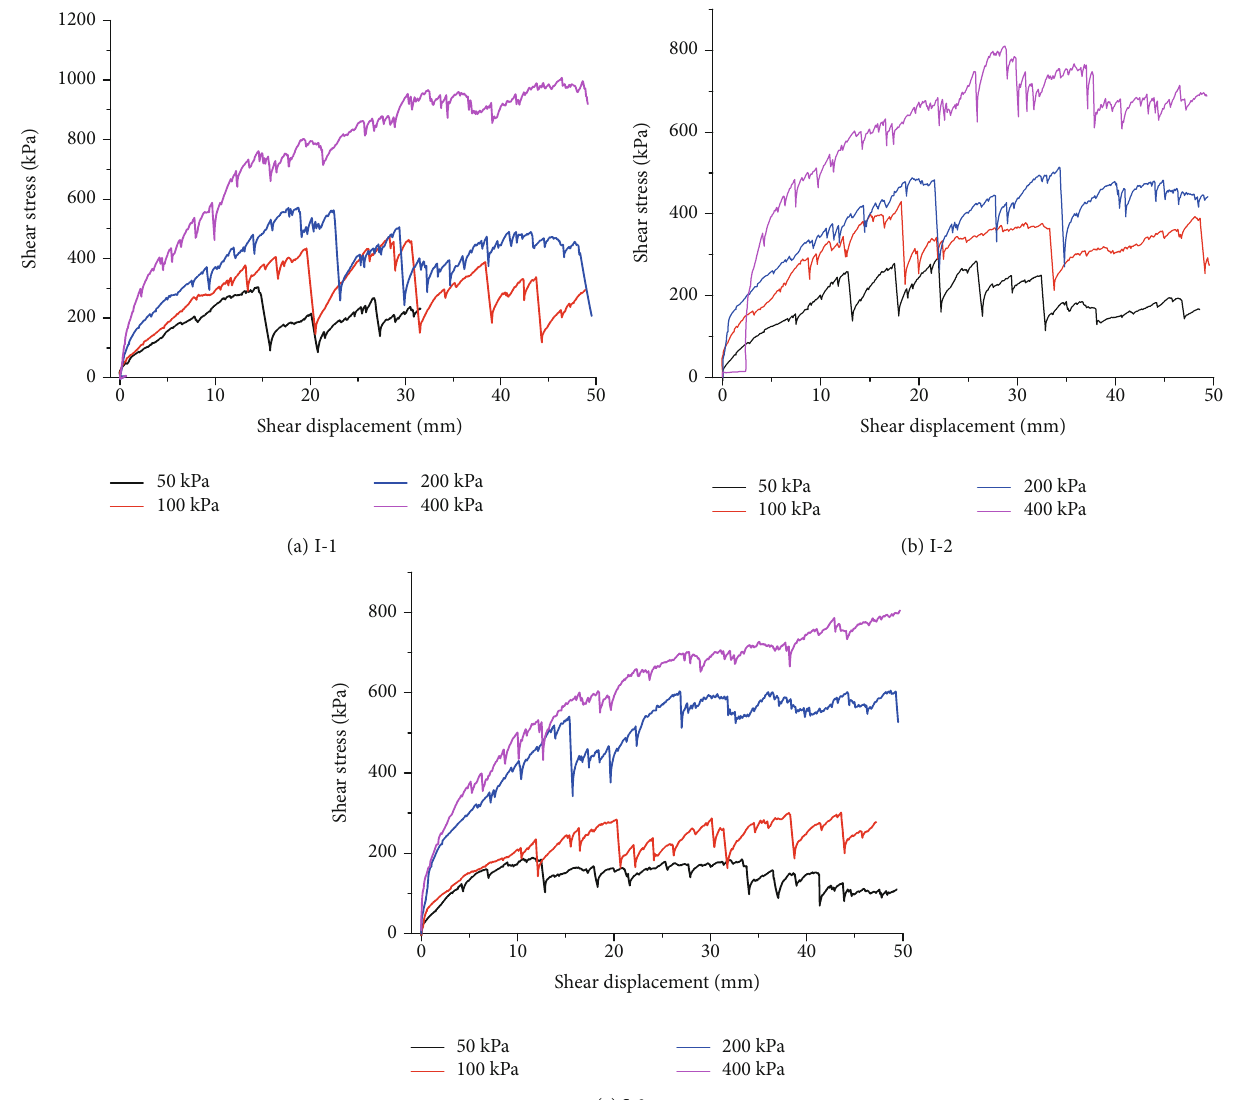
Figure 2: Shear stress versus shear displacement curves of group I (large particle